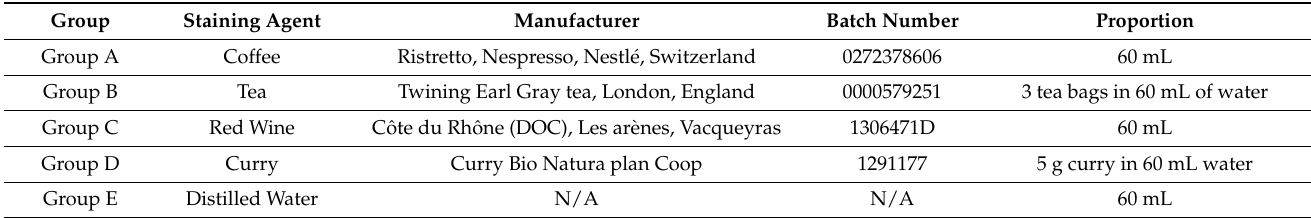
Table 1. Details of staining solution.